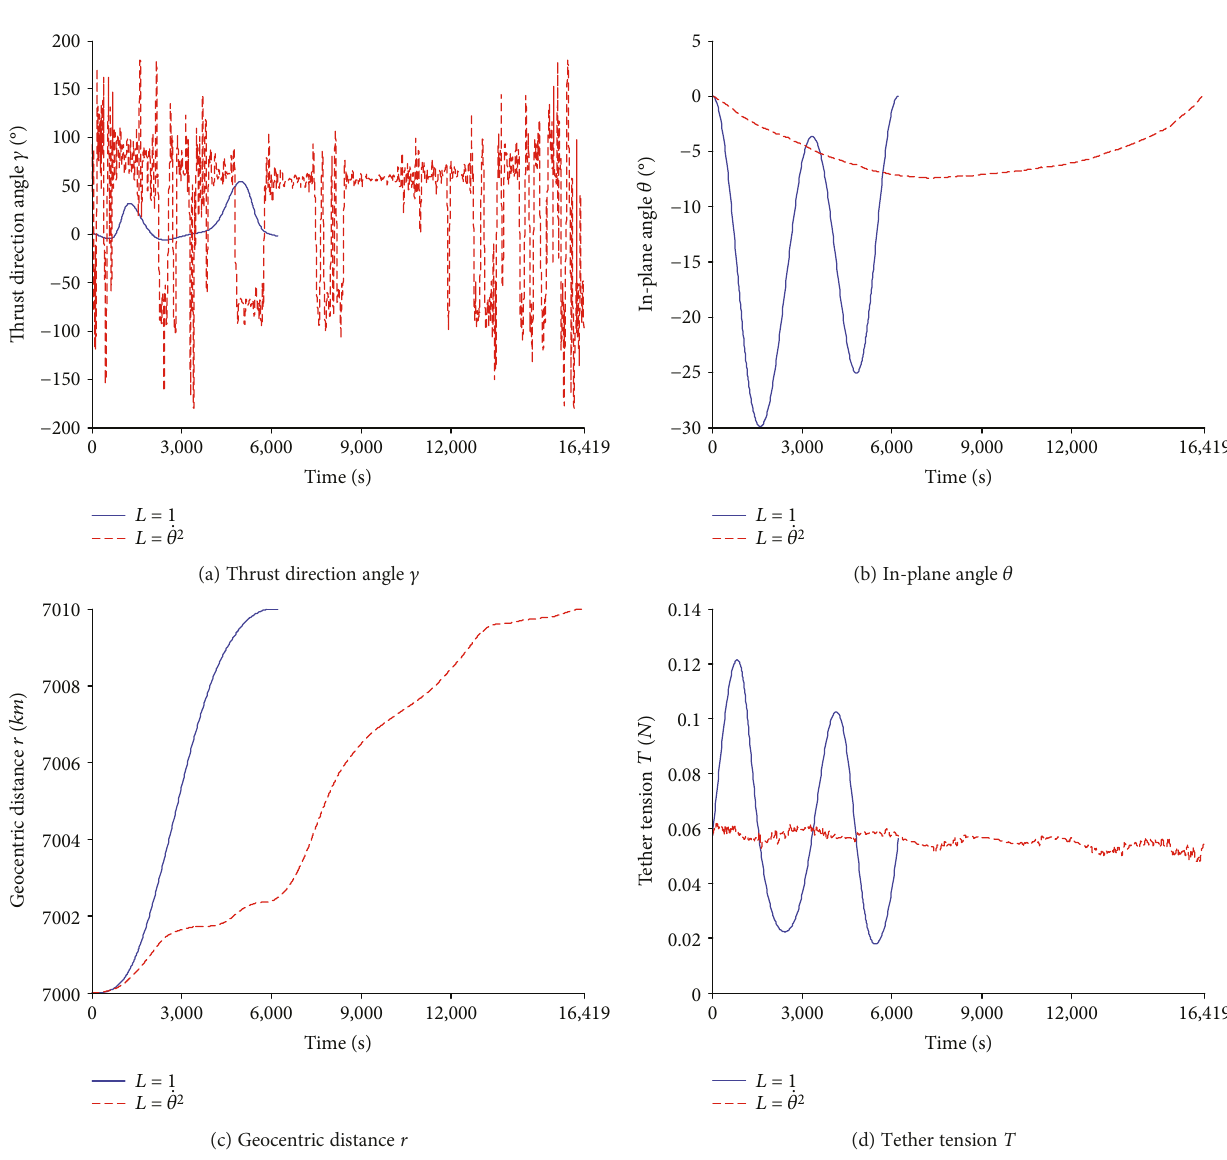
Figure 4: Time responses of the tethered system under thrust